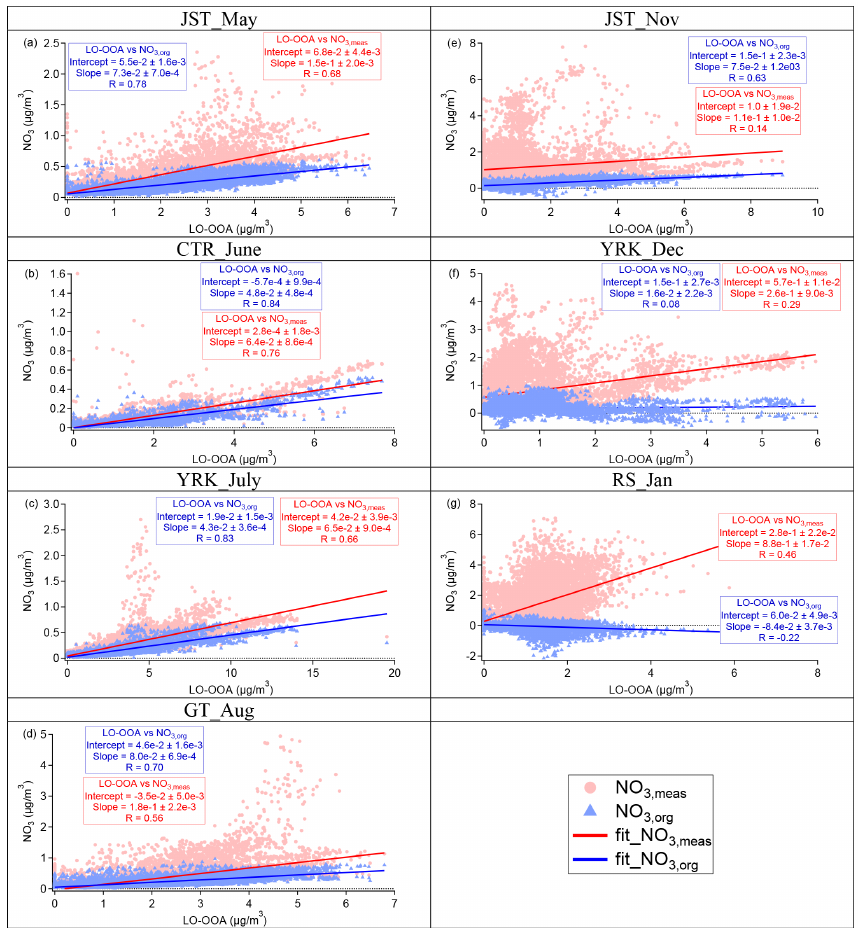
Figure 9. Scatter plot of LO-OOA vs. the total measured nitrates (i.e., NO 3 , meas ) and LO-OOA vs. estimated concentration of “nitrate functionality from organic nitrates” (i.e., NO 3 , org ) by using R ON = 10 in the NO + x ratio